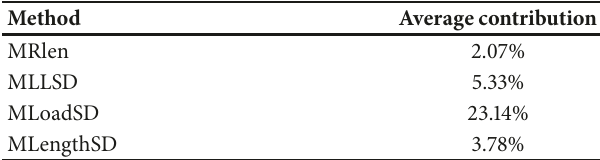
Table 3: Contribution of the local search of each